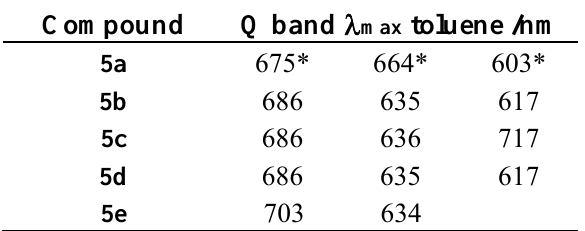
Table 3. The Q band maxima of compounds 5 after purification by TLC.